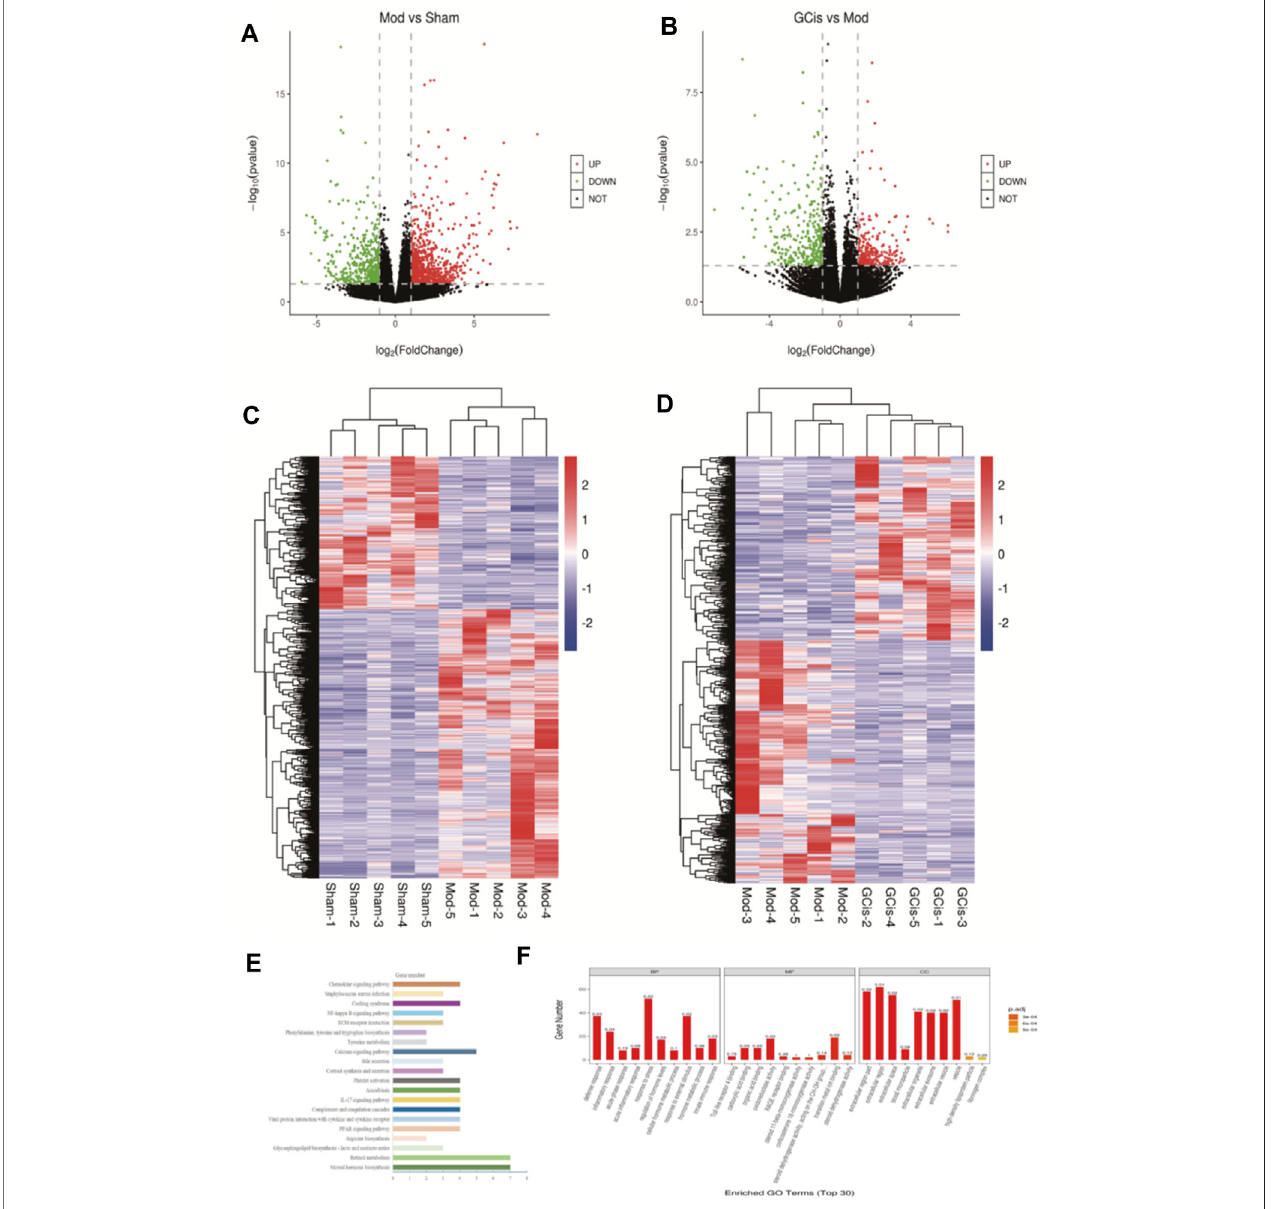
FIGURE 6 | Transcriptome analysis of DEGs in the ileum. The upregulated (red) or downregulated (blue) genes (A) . (C) Sham group vs . model group (B) . (D) GCis group vs . model group. Bioinformatics analysis (GO and KEGG annotation) of 228 DEGs. (E) GO analysis of GCis 228 DEGs. (F) KEGG analysis of GCis 228 DEGs.